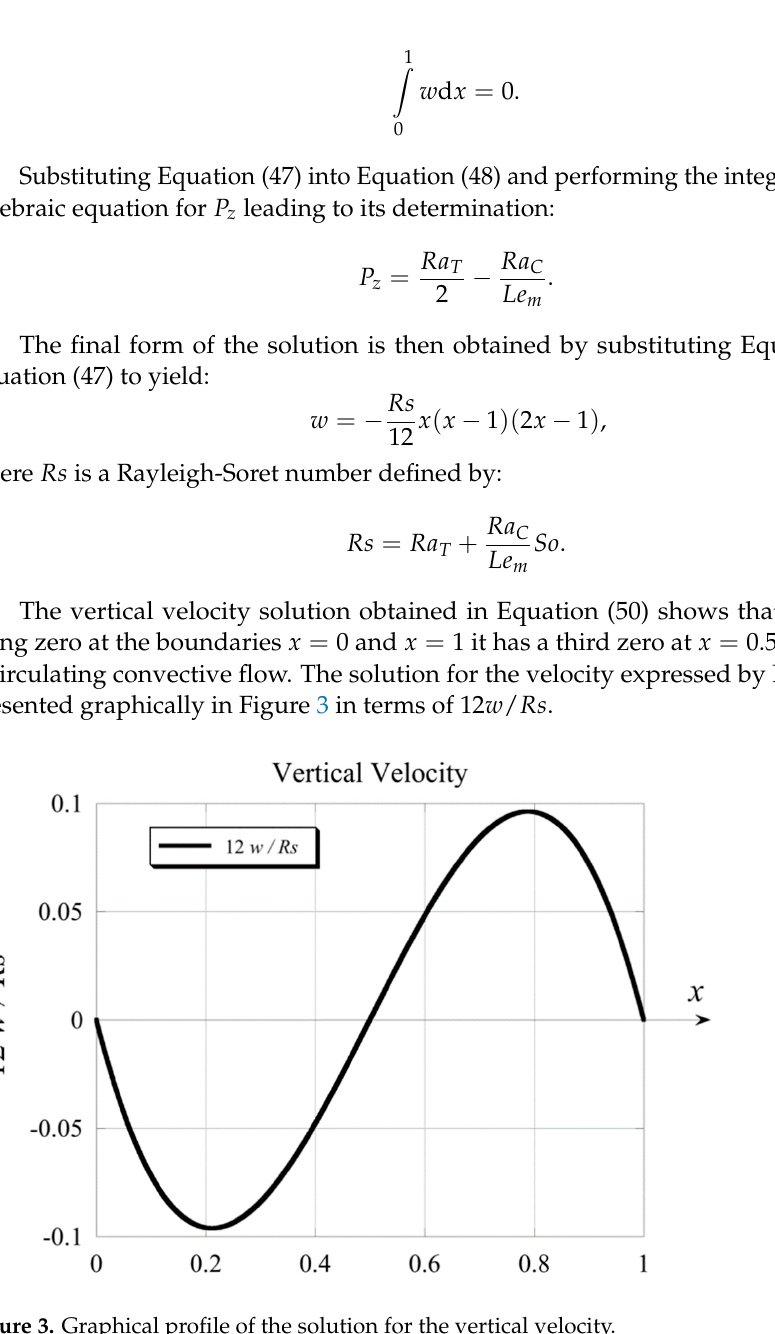
Figure 3. Graphical profile of the solution for the vertical velocity.